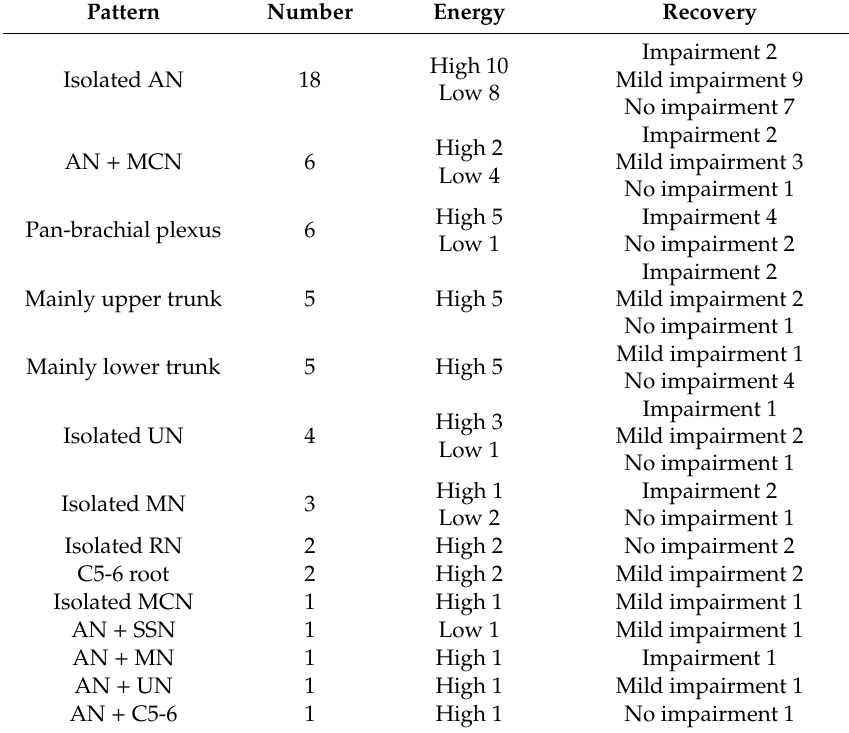
Table 5. Summary of Peripheral Nerve Injuries Based on the Electrodiagnostic Investigation in Patients with Shoulder